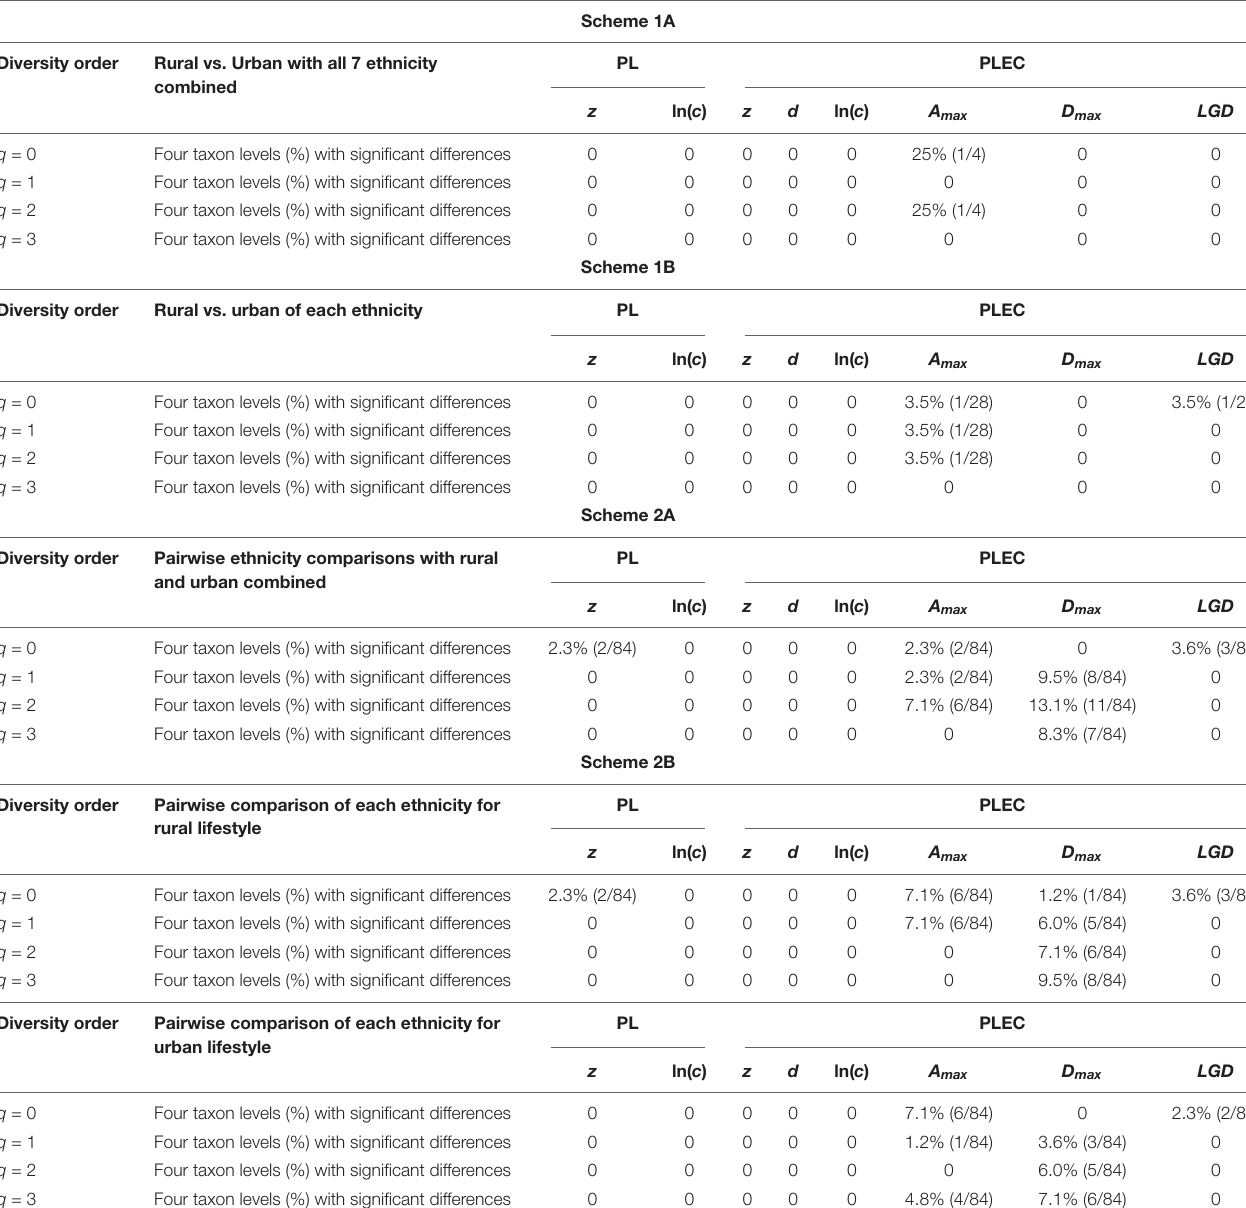
TABLE 2 | The results (percentages with significant differences) of the permutation tests for the differences in the parameters of the DAR models for the pairwise comparisons of Chinese gut microbiome datasets [see Supplementary Table 2 for specific results ( p -value) of the four schemes (1A–2B)]. Scheme